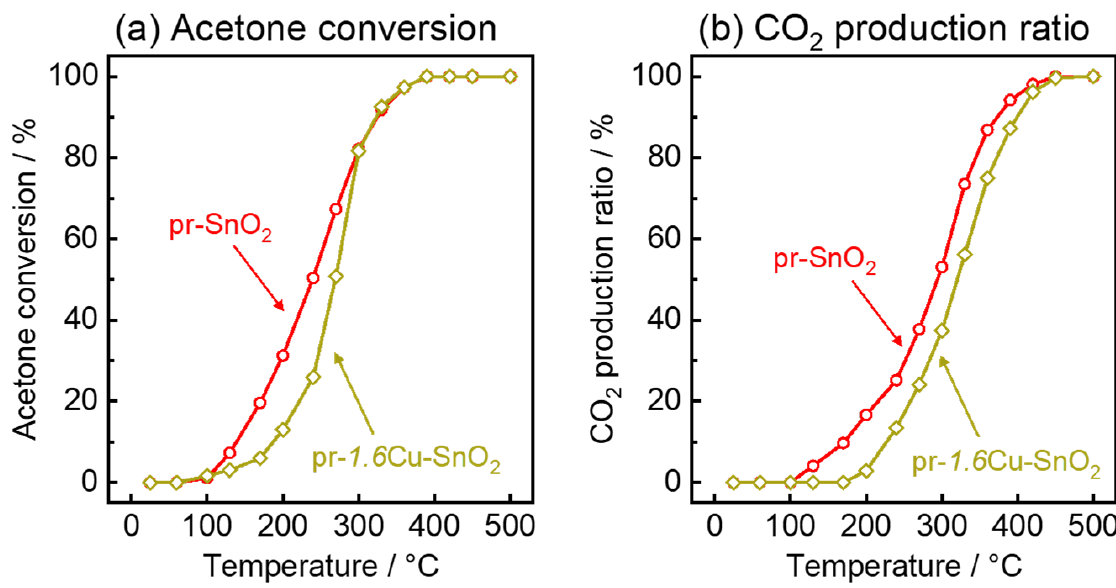
Figure 10. Catalytic combustion behavior of 100 ppm acetone over pr-SnO 2 and pr- 1.6 Cu-SnO 2 powders in air; ( a ) acetone conversion, ( b ) CO 2 production ratio.